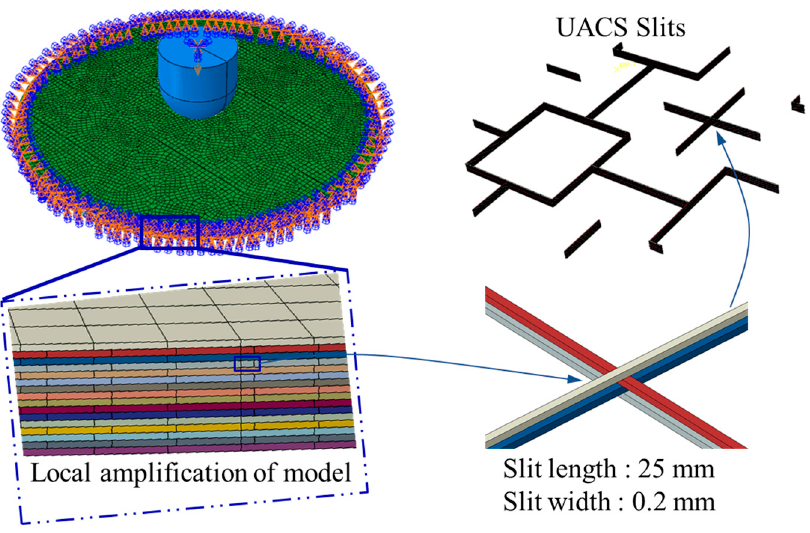
Figure 3. Model of UACS composite laminates under low-velocity impact. The eight-node solid elements with reduced integration (C3D8R) were used in the plate. Table 1 shows the details of the material properties of the prepreg used in this research. These parameters were provided by the manufacturer of prepreg (Weihai Guangwei) based on experimental analysis and empirical calculation. In addition, the zero-thickness eight-node three-dimension cohesive elements (COH3D8) were inserted between adjacent layers to simulate delamination. In order to improve the computational accuracy and efficiency, the mesh with an element size of 1 mm × 1 mm was used in the model. Therefore, the mesh of composite laminates consisted of 99216 C3D8R elements and 93015 COH3D8 elements. Regarding the interface cohesive element, Liu [33] selected the best parameters for the cohesive element in their work after comparing the impacts of various contact strengths on crack propagation damage. Table 2 lists the parameters of the interface cohesive elements that were employed in this investigation. All freedoms along the periphery of the plate were constrained to zero to simulate the experimental clamped conditions. A general contact algorithm in ABAQUS/Explicit was adopted to simulate contact between the impactor and the plate, as well as ply to ply in the laminate. The penalty method with a friction coefficient was used to describe the tangential behavior, while the hard contact method was employed to describe the normal behavior. Between the layers, there was an average friction coefficient of 0.5, and between the impactor and the plate, it was 0.3 [22,34]. Typically, the two categories used to describe the damage types of composite laminates under low-speed impact are intralaminar damage (matrix cracking and fiber breaking) and interlaminar damage. Damage simulations, including the damage initiation criterion and damage propagation law, can simulate the impact damage process. The equivalent displacement model selected in this paper has good accuracy for simulating damage development